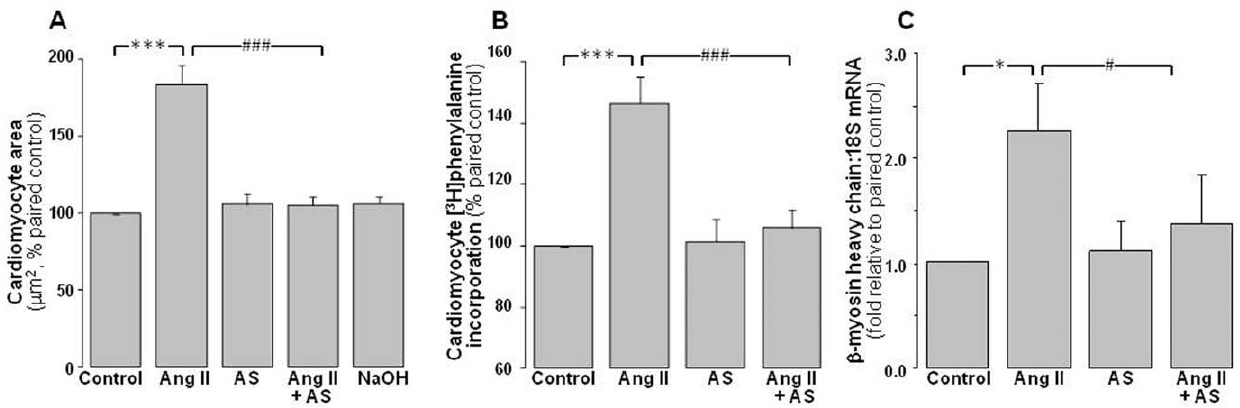
Figure 1. Antihypertrophic actions of Angeli’s salt. Ang II (1 m mol/L, 48 h)-stimulated cardiomyocyte hypertrophy is abolished by Angeli’s salt (AS, 1 m mol/L, added 4 6 /day over 48 h). This is evident on A cardiomyocyte area (n=10 myocyte preparations); B de novo protein synthesis